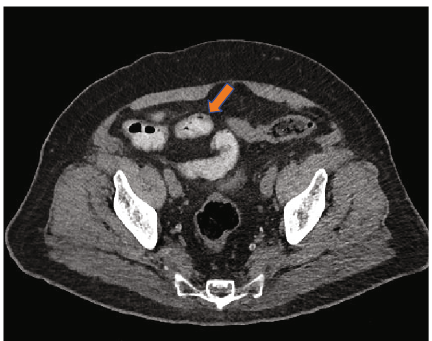
Figure 1: CT scan depicting focal wall thickening of the distal ileum and surrounding fat stranding and air loculi along the wall of the distal ileum